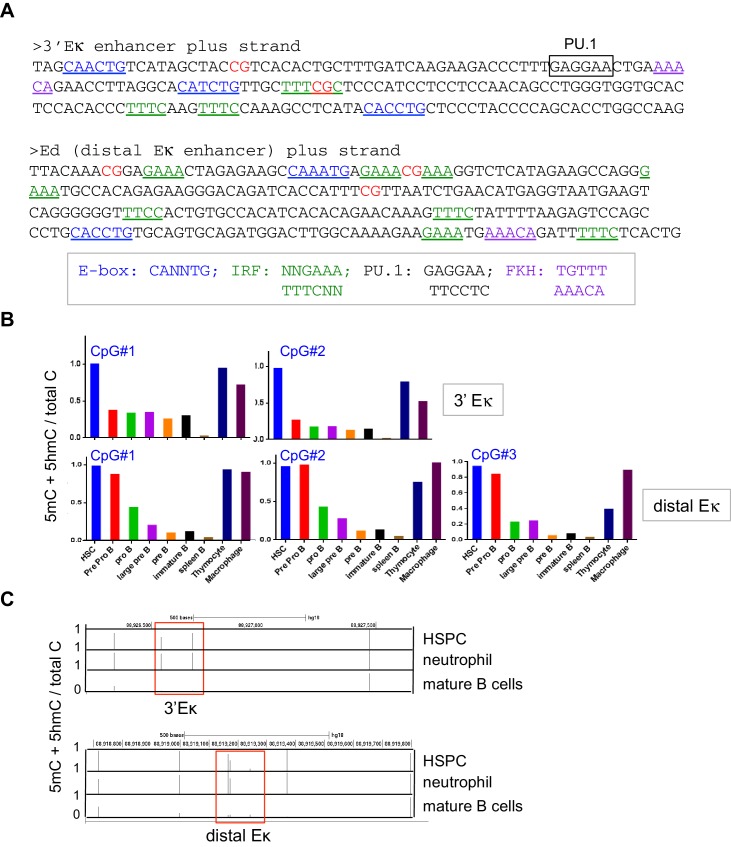
The 3’Eκ and distal Eκ enhancers undergo B cell specific-loss of cytosine modification.(A) DNA sequences of the 3’Eκ and distal Eκ enhancers. CpG dinucleotides, consensus E-box, IRF, PU.1, and FKH motifs are indicated. (B) The 3’Eκ and distal Eκ enhancers undergo B cell-specific DNA ‘demethylation’. Control cell types and B cells at various developmental stages indicated were sorted and the DNA modification status (5mC + 5 hmC) of the 3’Eκ and distal Eκ enhancers were analyzed by bisulfite sequencing as in Figure 3C. (C) The 3’Eκ and distal Eκ enhancers undergo B cell-specific ‘demethylation’ (loss of 5mC + 5 hmC) in human B cells. Shown is the DNA modification status of human hematopoietic stem/ precursor cells (HSPC), neutrophils and B cells based on published whole-genome bisulfite sequencing data (GSE31971)(Hodges et al., 2011). Bars indicate the average fractional modification of each CpG. The regions corresponding to the 3’Eκ and distal Eκ enhancers are indicated with rectangles. Note CpG sites outside of the enhancers remain fully methylated in B cells.